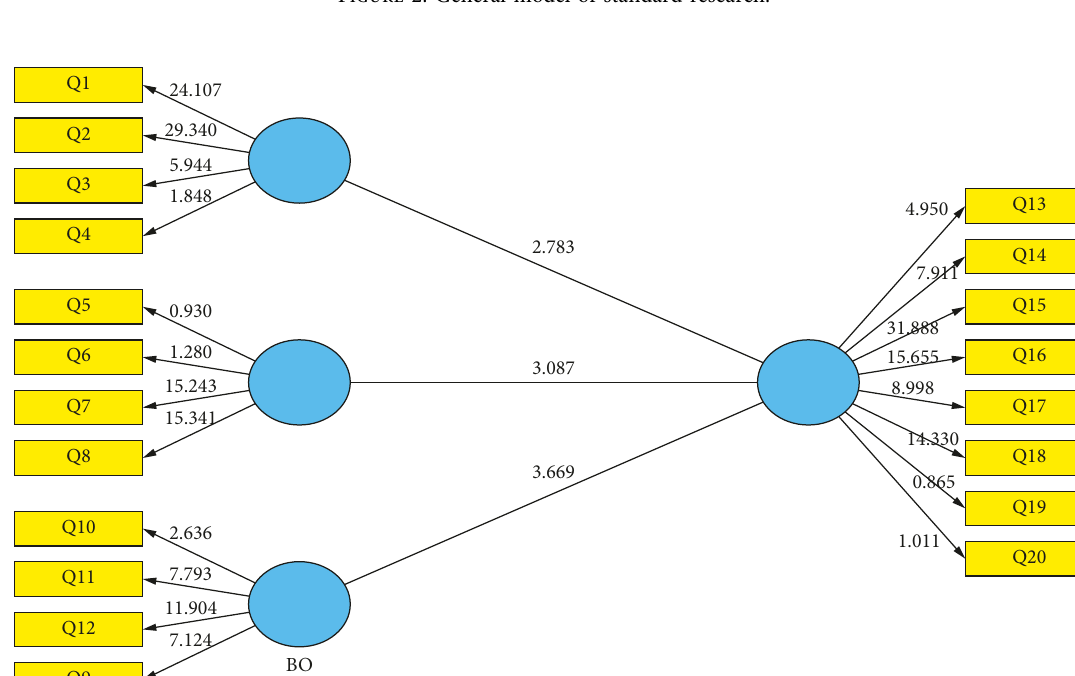
Figure 2: General model of standard